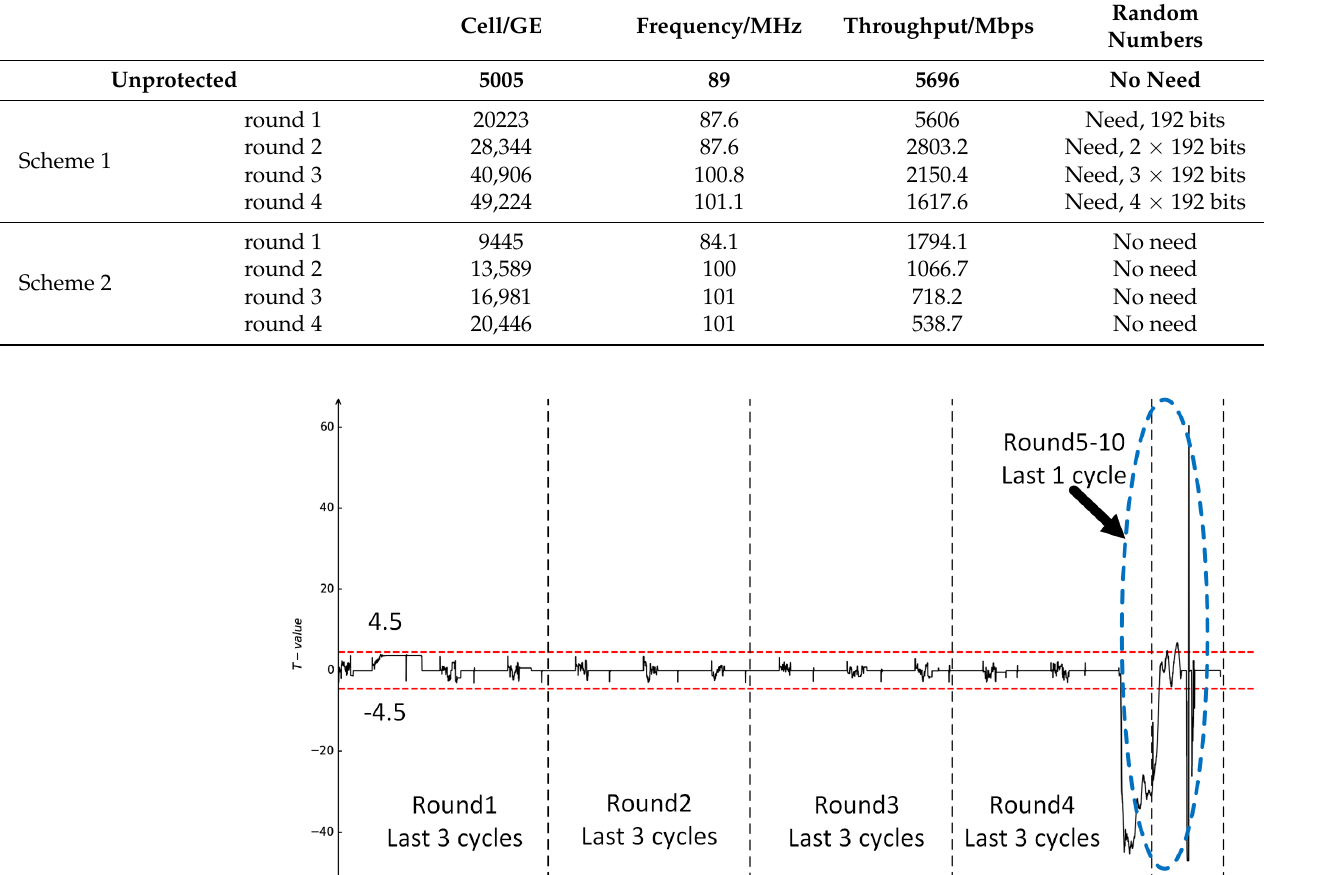
Table 6. Countermeasure evaluation and comparison.